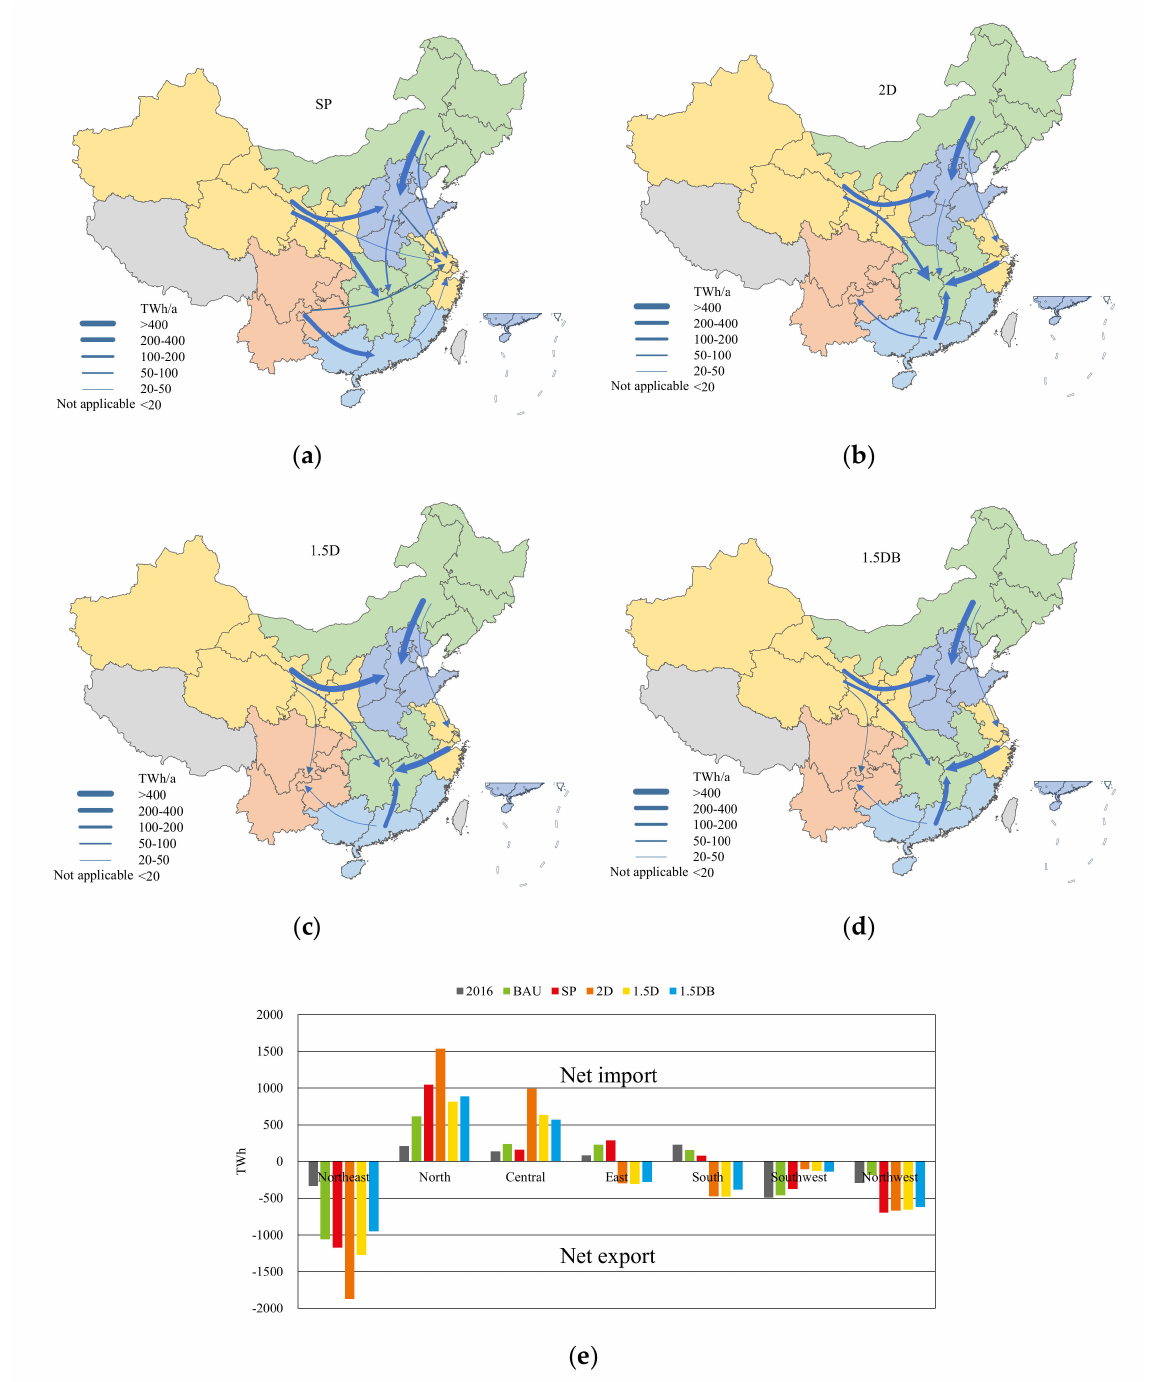
Figure 4. Power flows amongst regions in 2050: ( a ) Stated policy scenario; ( b ) 2-Degree scenario; ( c ) 1.5-Degree scenario; ( d ) 1.5-Degree scenario with blue hydrogen; ( e ) Comparison amongst